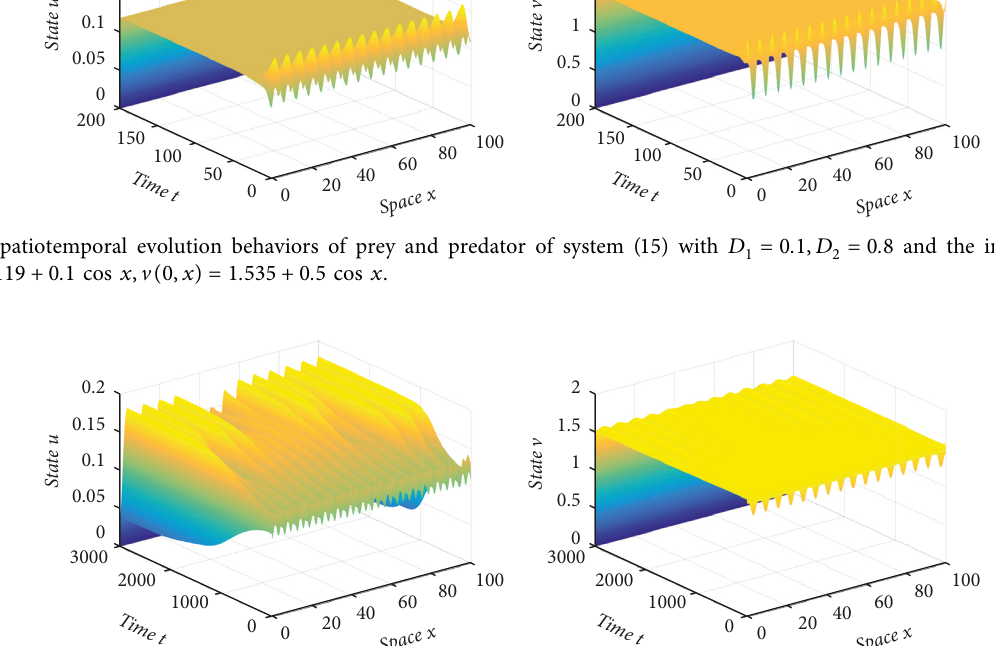
� 0 . 02 , D � 5 and the initial condition 1 2